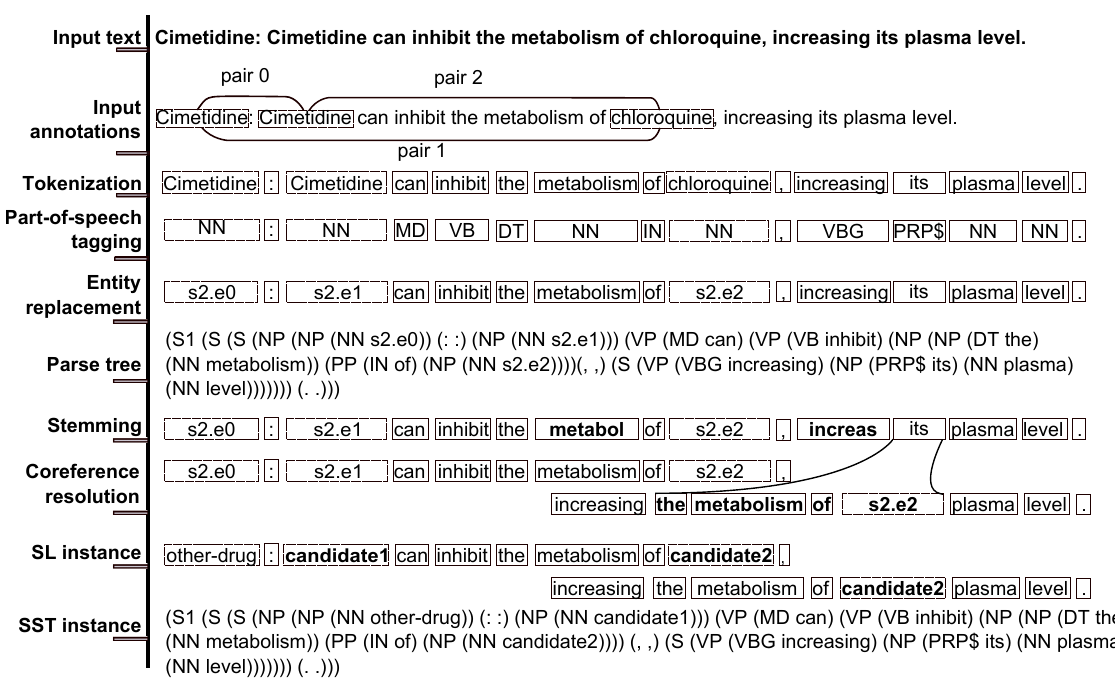
Figure 1: Pre-processing transformations on the input text for the RE